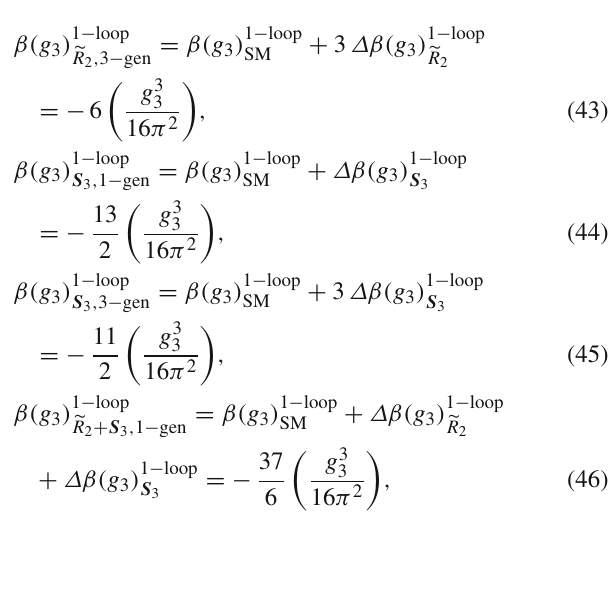
Fig. 1 Running of gauge coupling g 2 with the energy scale μ for SM and different leptoquark scenarios with one loop and two loops. The green curve represents the SM; the red and yellow curves signify the extension of the SM with one and three generations of (cid:2) R 2 , respectively; the addition of one and three generations of S 3 to SM are indicated by